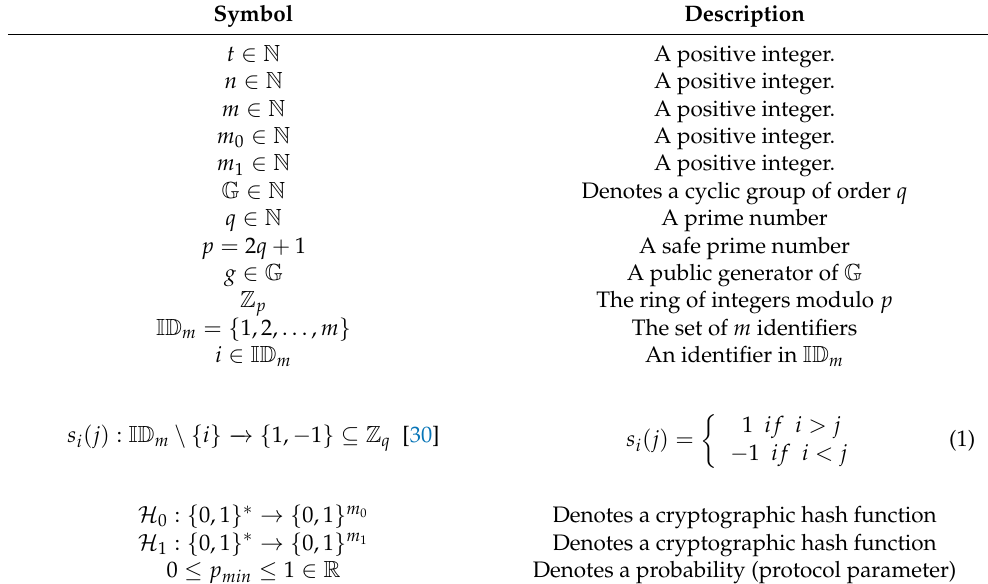
Table 1. Summary of